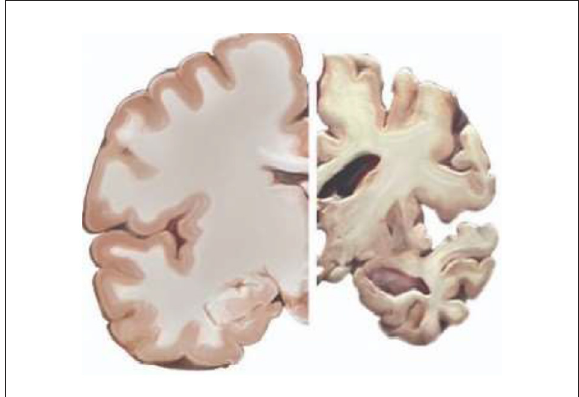
FIGURE1 Healthy brain (Left) and Alzheimer’s affected brain (Right) *